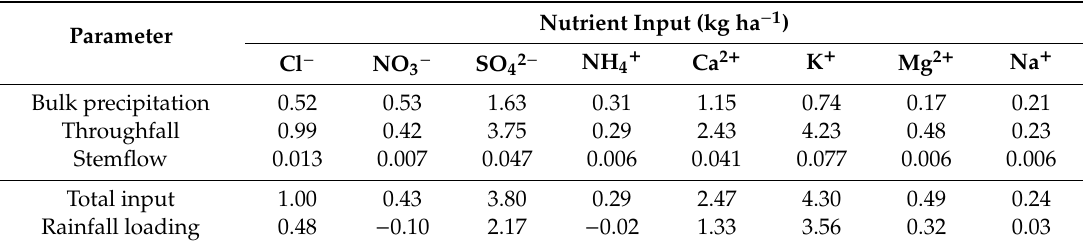
Table 3. Macronutrients fluxes in water of di ff erent type of pathways in comparison to total input, and rainfall loading during the vegetation